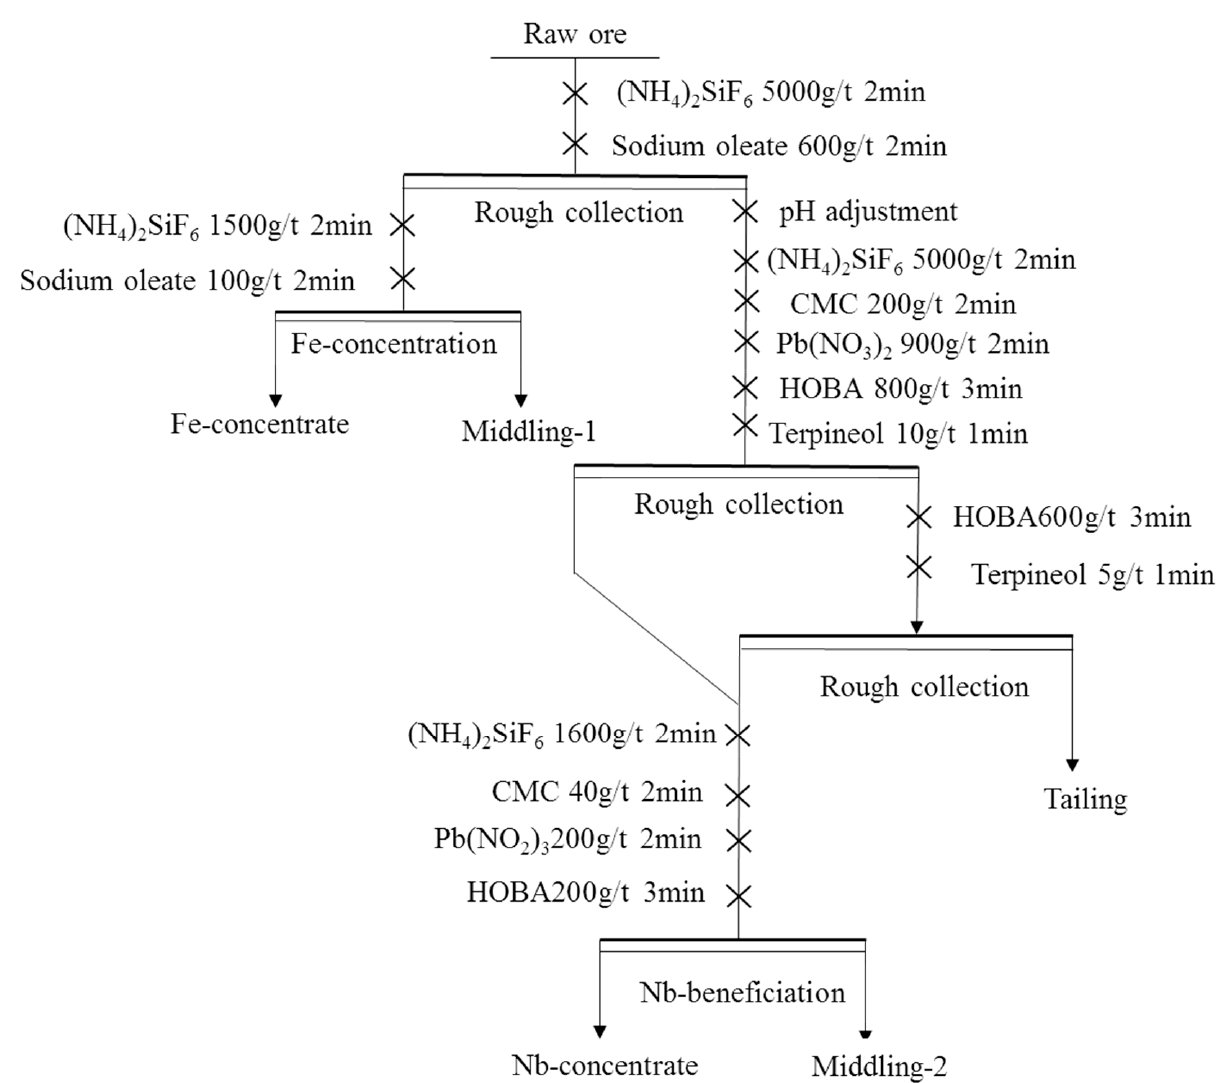
Figure 2. The flowsheet of the flotation optimization experiments.